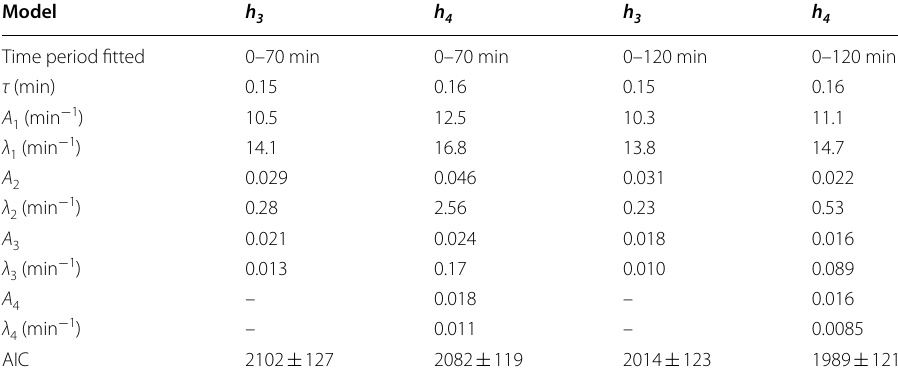
Table 2 Final PBIF parameters